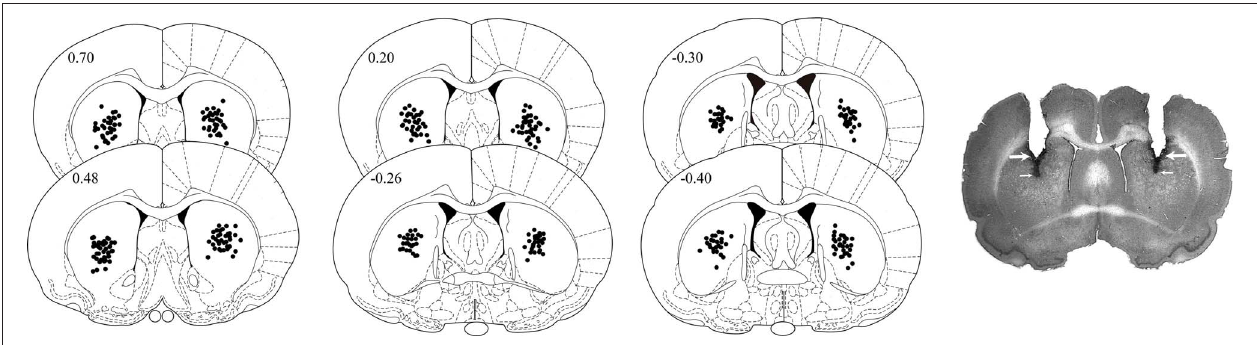
FIGURE 1 | Diagrams and photomicrograph illustrating the placement of injection needle tips within the dorsal striatum of rats trained on the inhibitory avoidance task. Large arrows point to the tracks left by the